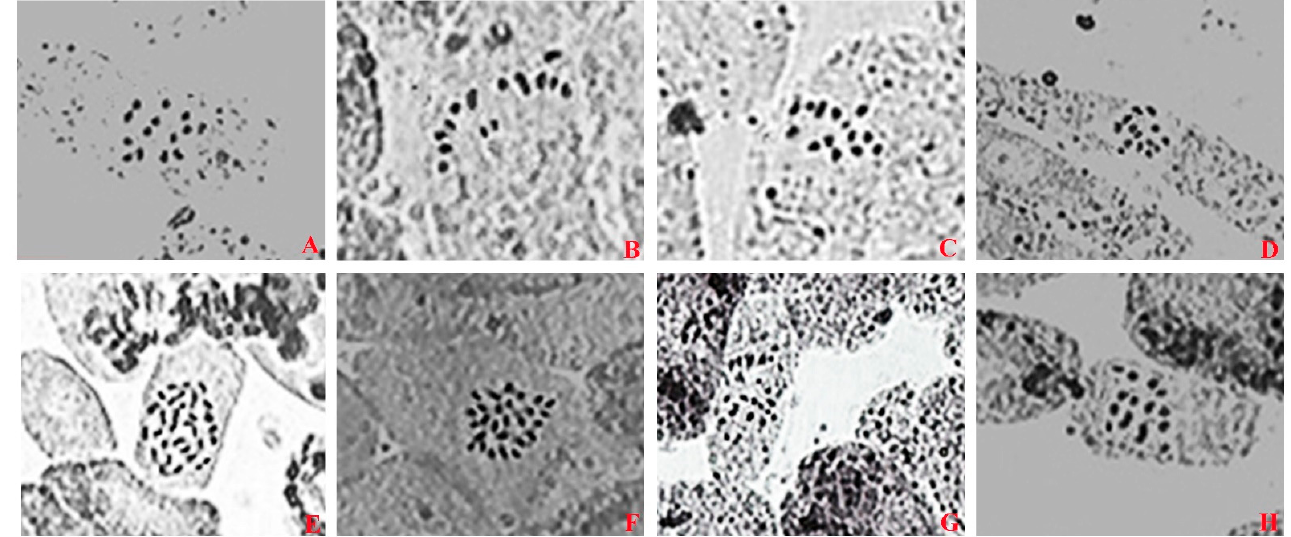
Figure 8. The number of chromosomes in root-tips cells of mutants in F. nilgerrensis . ( A ) YL: 2n = 2 x = 14; ( B ) CL: 2n = 2 x = 14; ( C ) NL: 2n = 2 x = 14; ( D ) SL: 2n = 2 x = 14; ( E ) RL: 2n = 4 x = 28; ( F ) WL: 2n = 4 x = 28; ( G ) SGL: 2n = 4 x = 28; ( H ) WT: 2n = 2 x = 14.